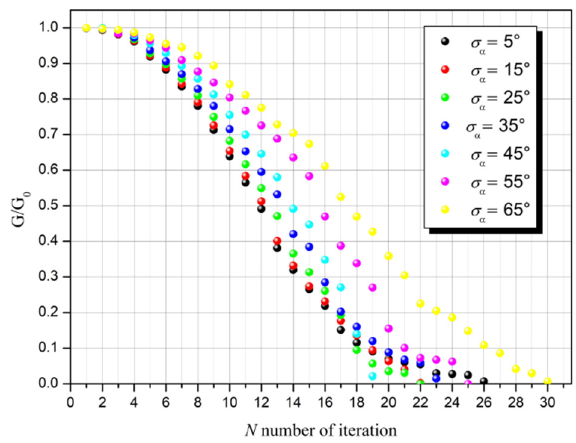
Figure 8. The conductivity ratio of the conductive layer with defects to the layer without defects calculated in subsequent iteration steps for various parameters of σ α .